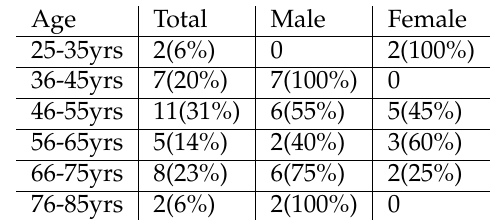
Table 1. Age and sex correlation in oral squamous cell carcinoma